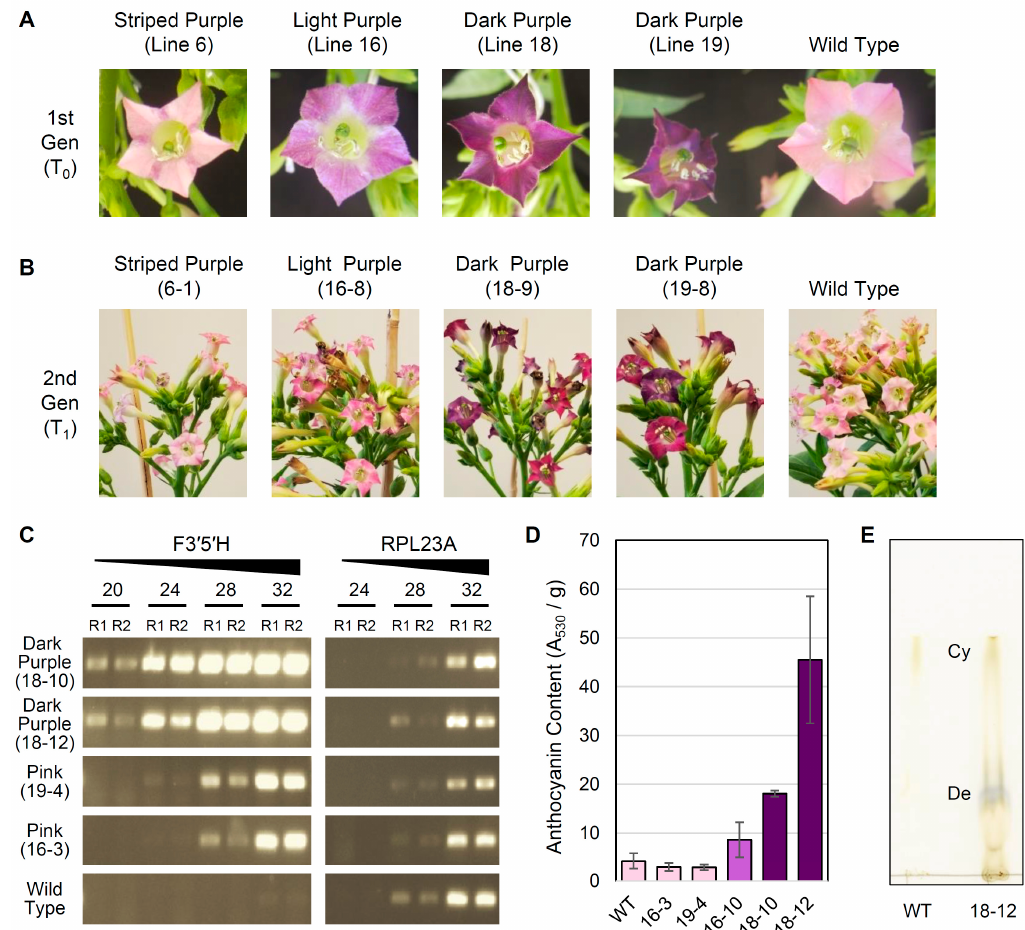
Figure 4. Characterization of transgenic tobacco lines. ( A ) Representative flowers from the T 0 generation and wild type tobacco. ( B ) Representative inflorescences from the T 1 generation and wild type tobacco. ( C ) Semi-quantitative reverse transcription PCR (RT-PCR) analysis of transgenic F3 (cid:48) 5 (cid:48) H and native RPL23A expression in T 1 individuals and wild type tobacco. RT-PCR reactions were stopped at 20, 24, 28, and 32 PCR cycles and run on a 1.5% agarose gel, and reactions were performed in replicate (R1, R2). ( D ) Mean ± 2 × SEM for anthocyanin content (measured as absorbance at 530 nm per g tissue) in stage 12 flowers from T 1 individuals and wild type (WT) tobacco. Histogram bars for each sampled individual are color coded according to approximate flower color. ( E ) Thin-layer chromatography comparing cyanidin (Cy) and delphinidin (De) content in flowers from line 18-12 and WT. As expected, the relative expression level of the F3 transgene was higher in T 1 plants